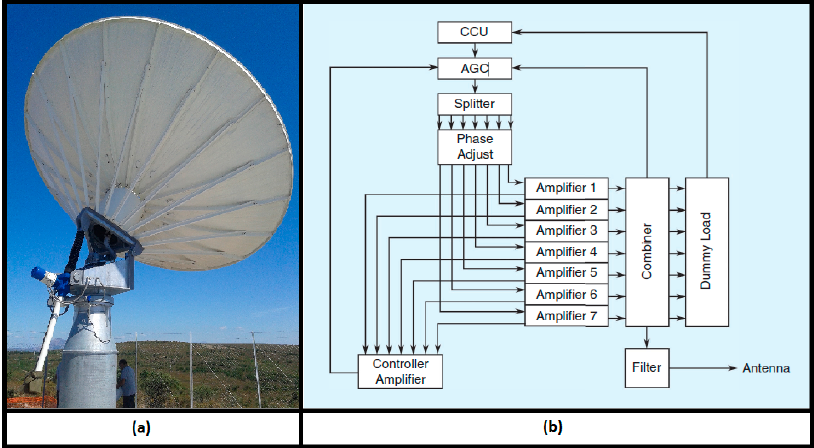
Figure 1. ( a ) The Radio Frequency Transmitter (TRF) antenna; ( b ) the block diagram of the trans- mitting